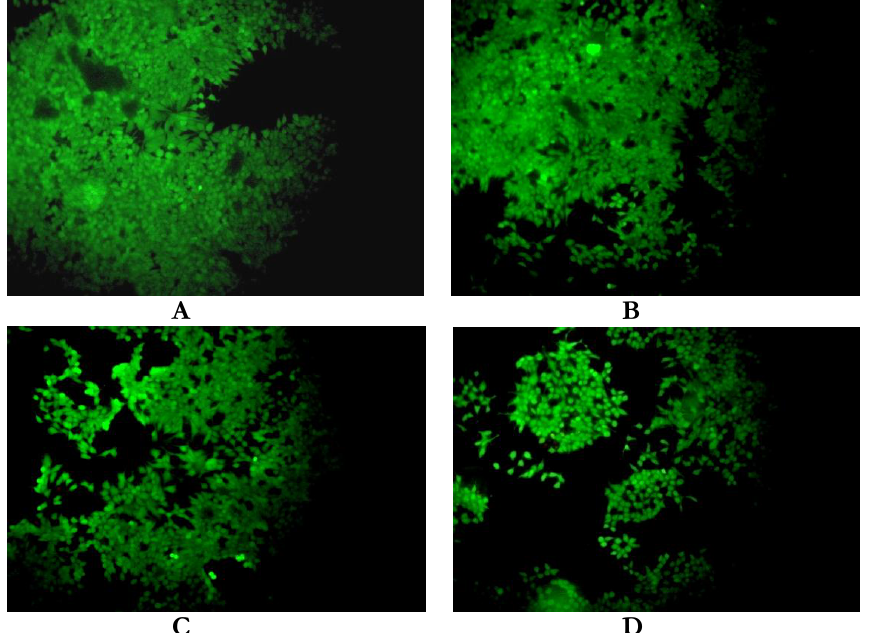
Figure 5. Calcein AM and Ethidium bromide-based staining of MCF-7. A=untreated, B, C, D= treated by tmx 1 µM, rhIFNα-2b standard and rhIFNα-2b in